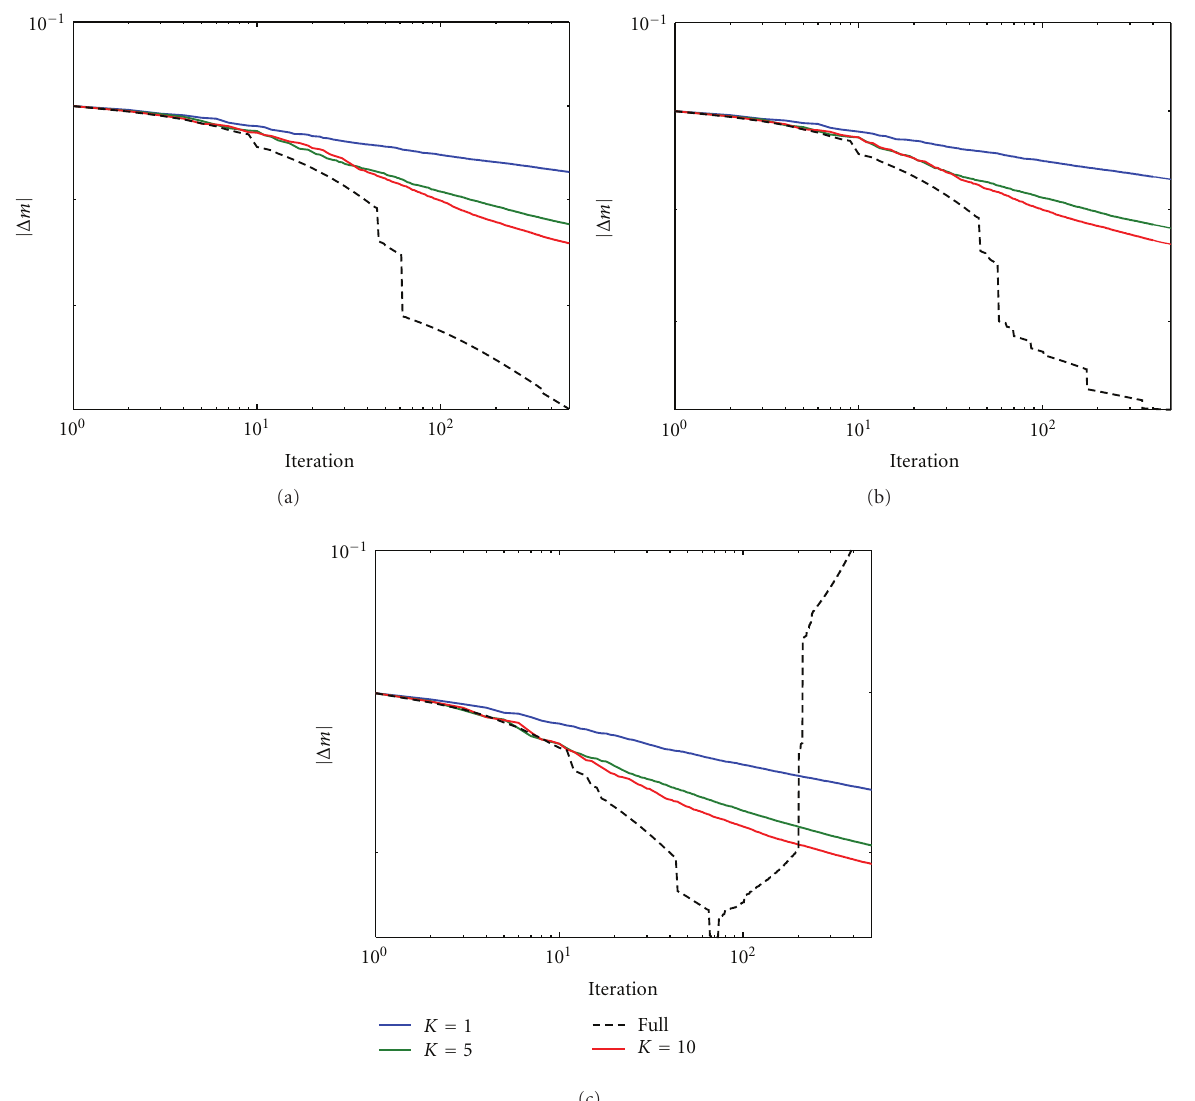
Figure 14: Error between the inverted and true model for the SA approach with full averaging for various batch sizes and the full problem, (a) without noise, (b) with noise (SNR = 20dB), and (c) with noise (SNR = 10dB). Averaging over the full past slows down the convergence